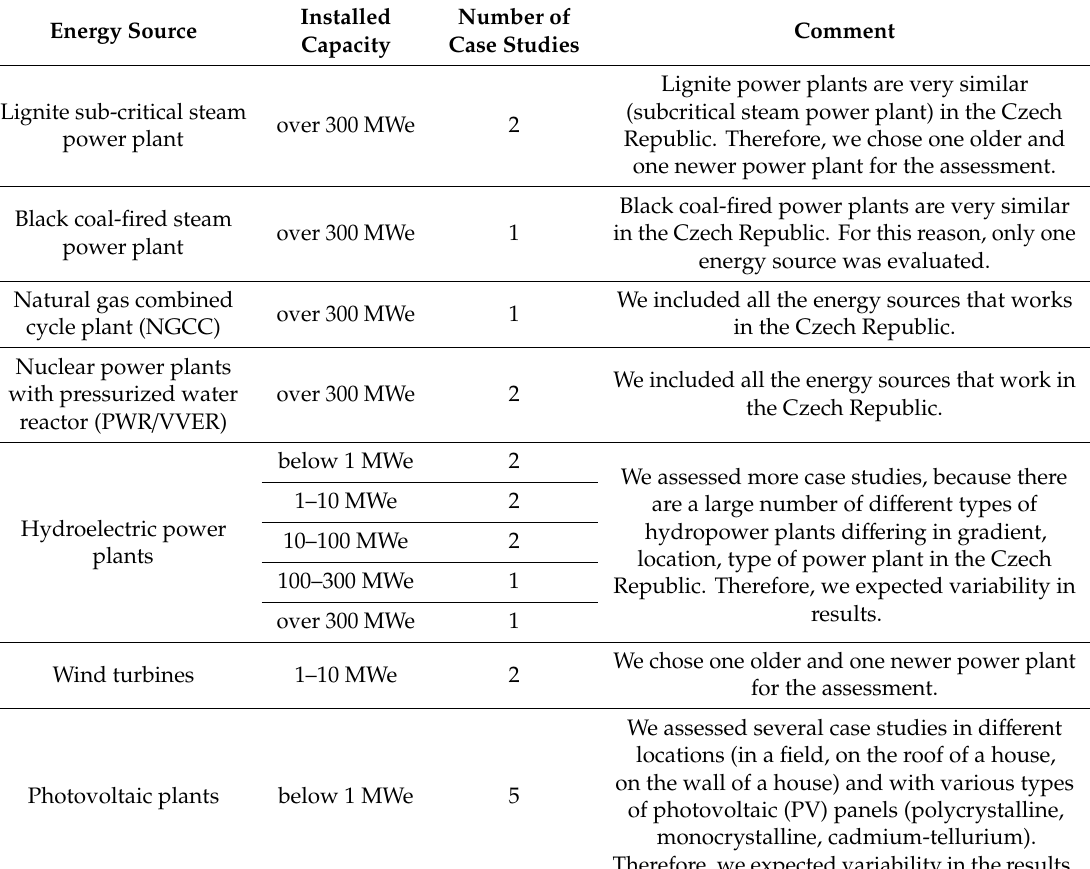
Table 2. Evaluated energy sources and installed